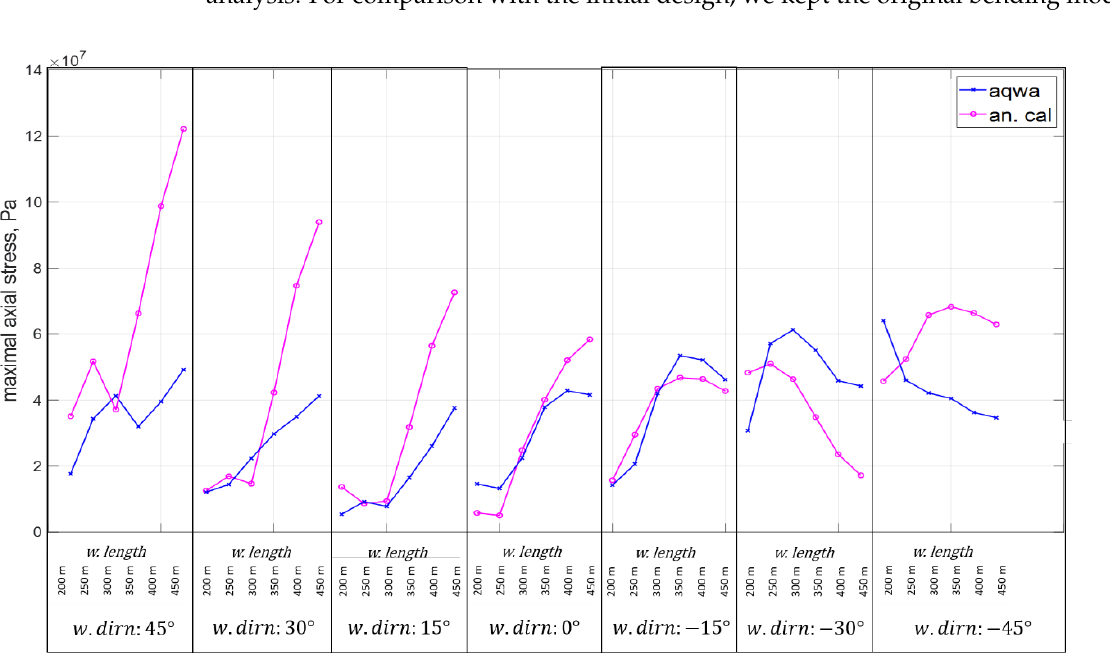
Figure 14. A comparison of the maximal axial stress in the X direction at the critical cross section. The wave splitting forces calculation by AQWA (complete hydrodynamic moments) is in blue. The hydrostatic analytic calculation is in magenta. Each subplot presents a wave direction. For each direction, the wavelength increased from 200 to 450 m.